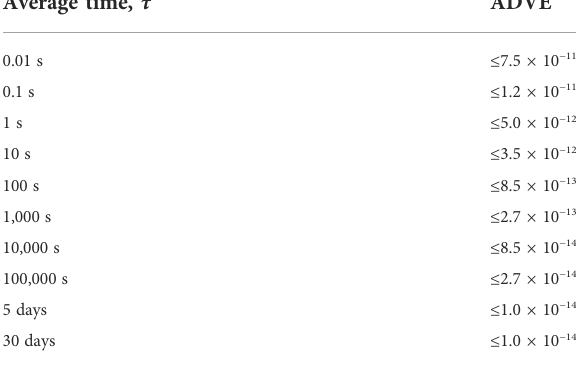
TABLE 2 Stability performance of the 5071A cesium clock primary frequency standard. Average time, τ ADVE